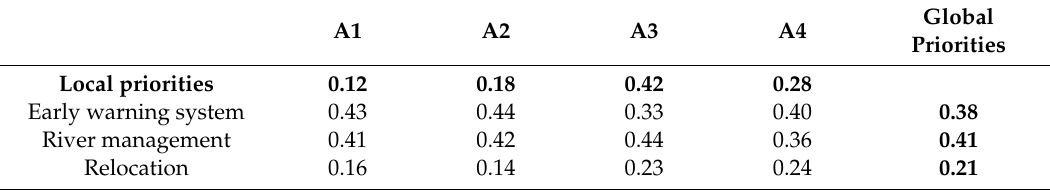
Figure 3. Contribution of the alternatives in reducing flash flood impacts. Table 6. Determining the global priorities through the synthesis of the local